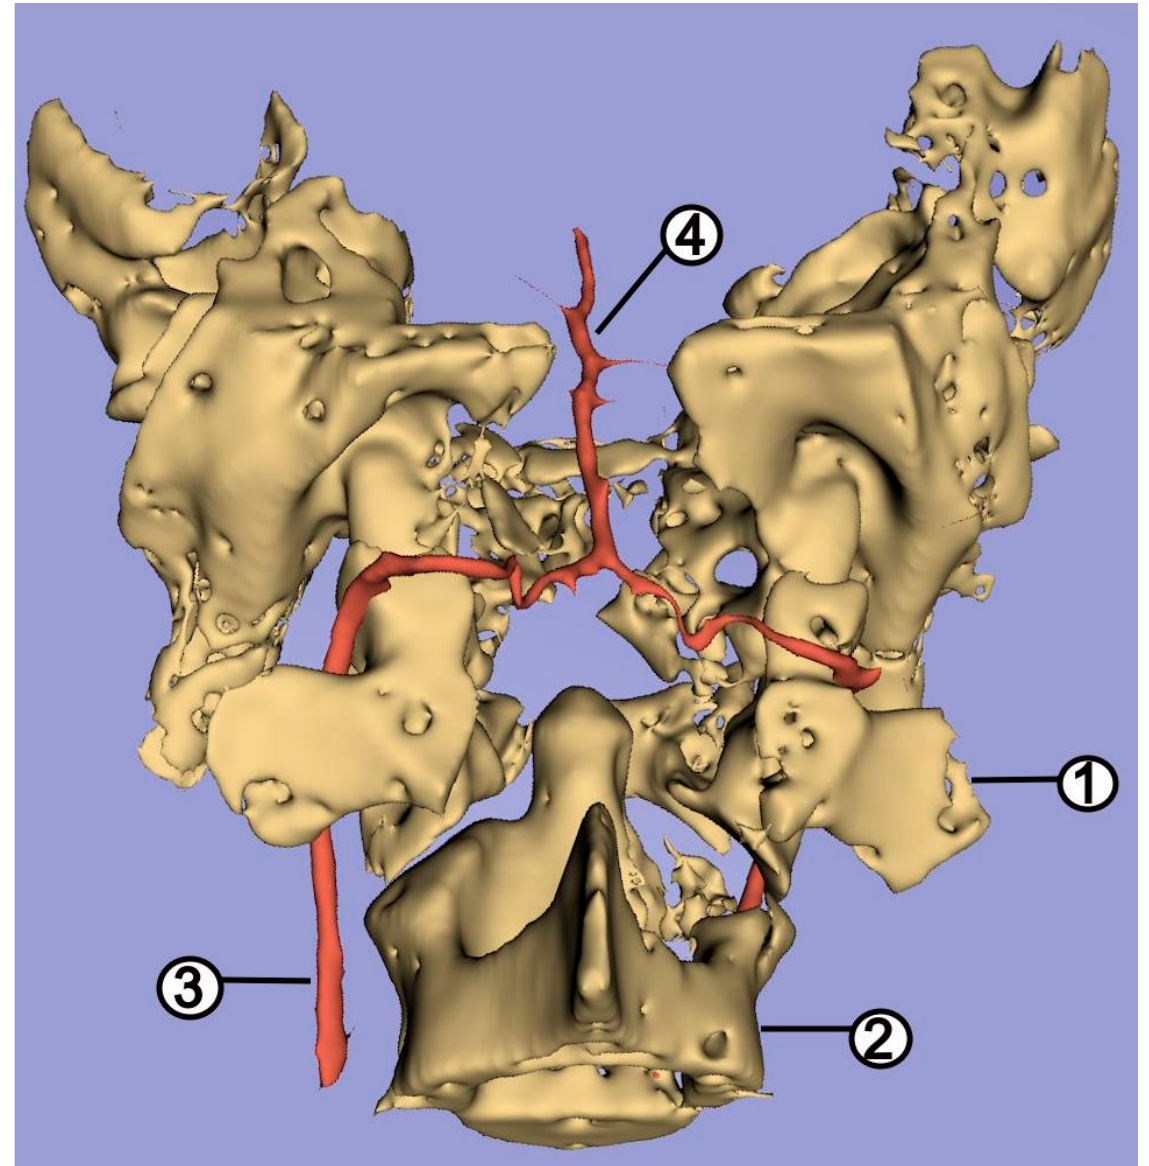
Figure 6. 3D reconstruction of the basal artery on bone scaffolding. 1—first cervical vertebra; 2—second cervical vertebra; 3—vertebral artery; 4—basilar artery.